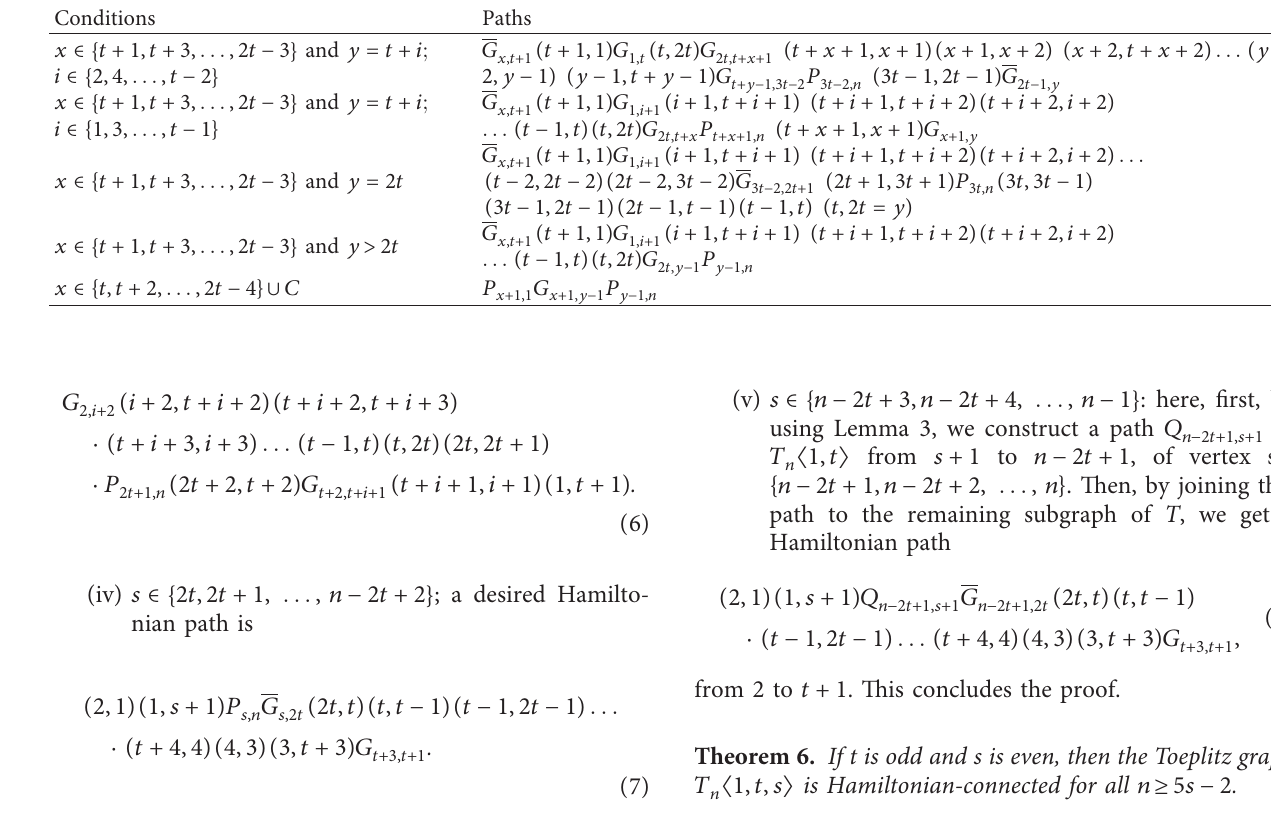
Table 4: Hamiltonian paths from 1 ≠ x to y in T when t is even. x, y ∈ B ∪